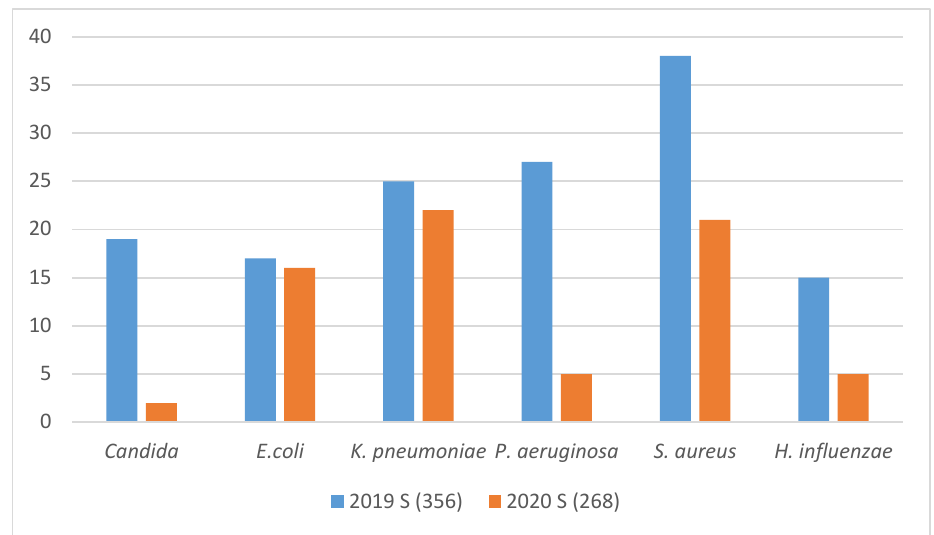
Figure 5. Bronchoalveolar lavage fluid cultures. Table 5. Bronchoalveolar lavage fluid cultures.